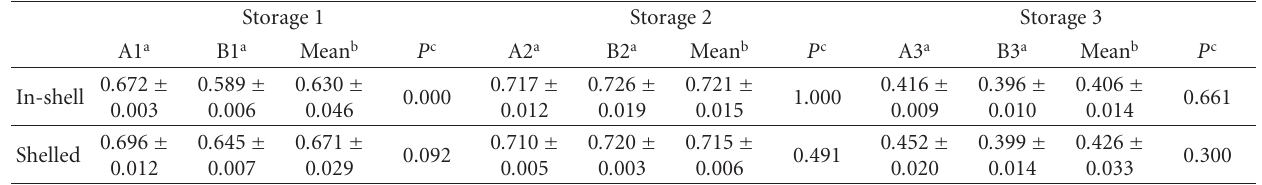
Table 1: Water activity of storage samples throughout the storage period.